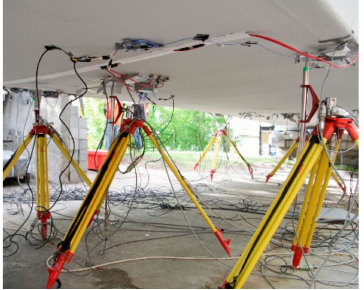
Figure 10. Inductive transducers used during measurements.